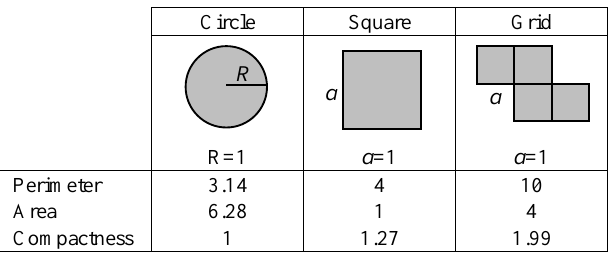
Table 1. The P2A compactness for circle, square and grid